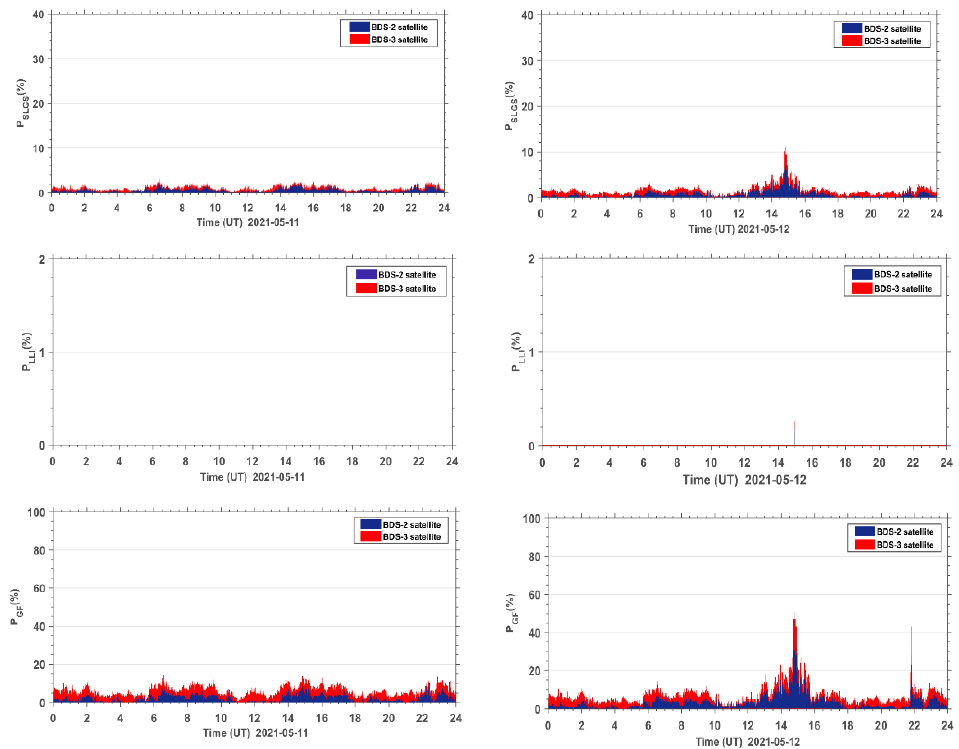
Figure 8. Time series of P SLGS , P LLI , and P GF for BDS sites worldwide during the reference day (11 May 2021) and the geomagnetic storm day (12 May 2021).